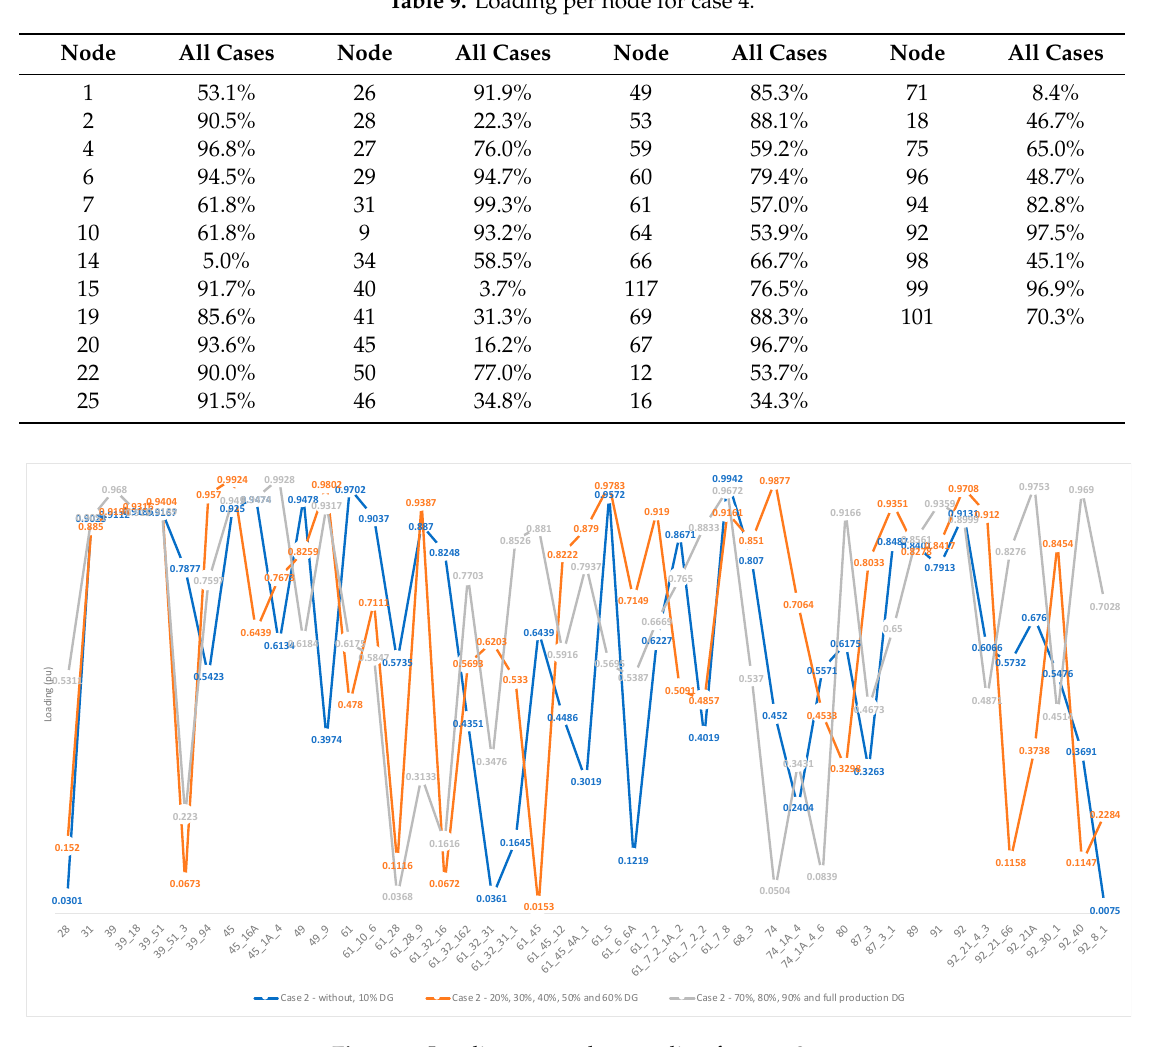
Figure 5. Loading per node according for case 2. Appl. Sci. 2019 , 9 , x Table 8. Loading per node for case 3.